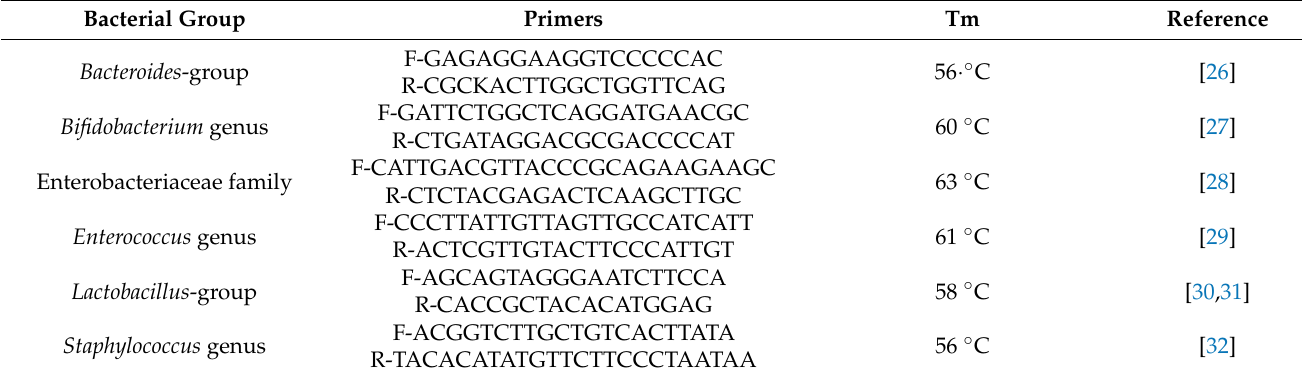
Table 1. Primers and PCR conditions for the different primer pairs used in this study. Bacterial